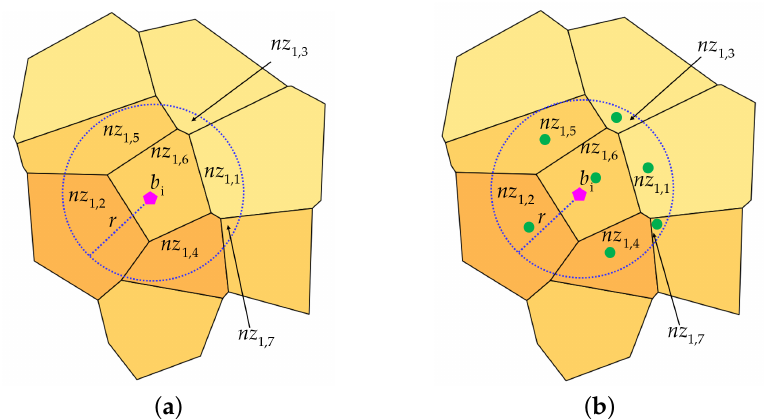
Figure 2. The nearest zones ( nz i , j ) inside the HazardArea i about building b i ( a ) and their centroids (the green dots) ( b ); ( i = 1, j =